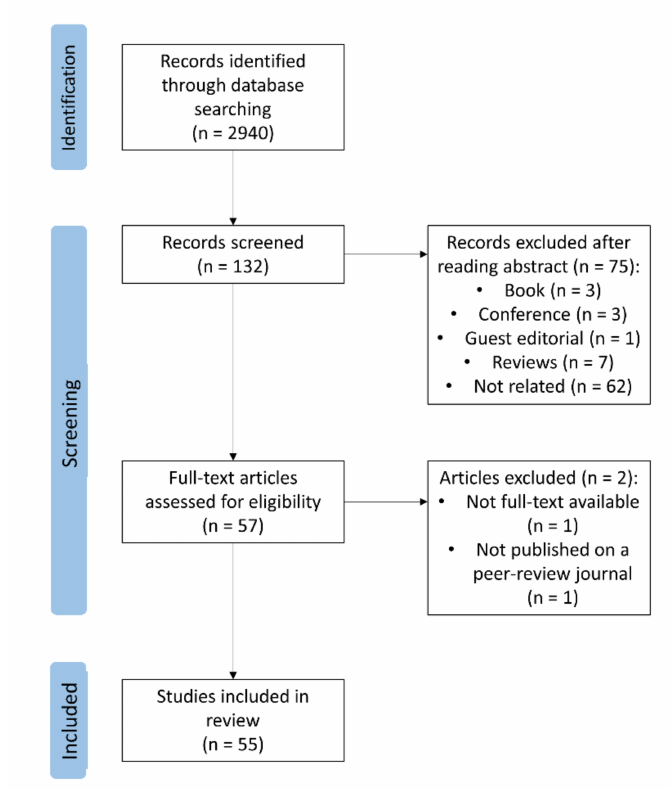
Figure 1. Flow chart for selection of